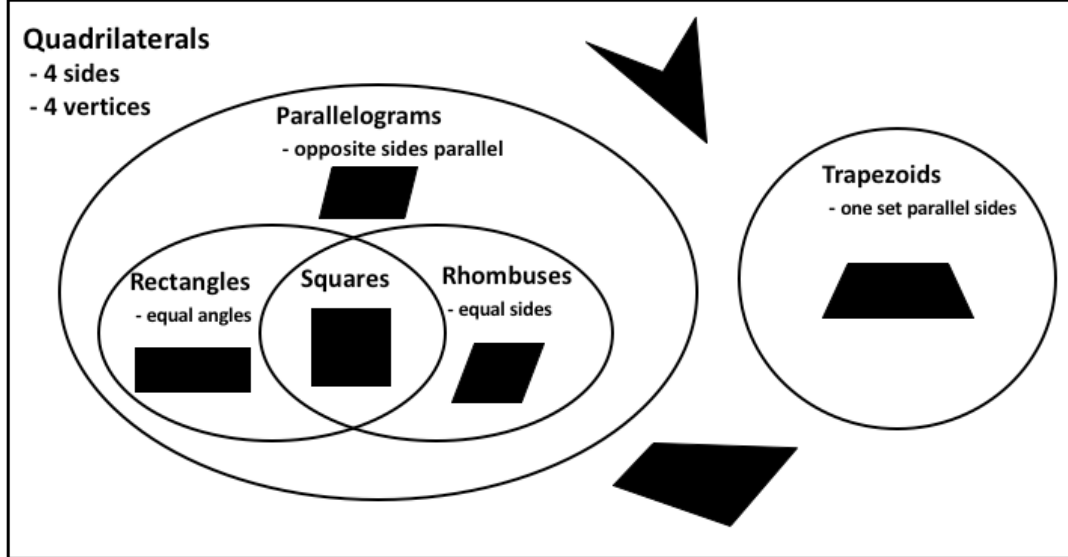
Fig 1: Classical